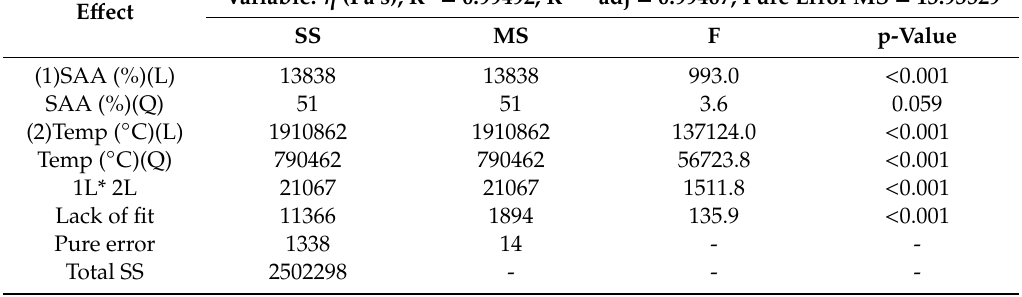
Table 8. Statistical significance of the e ff ects of SAA and test temperatures on dynamic viscosity of 50 / 70 bitumen (ANOVA). E ff